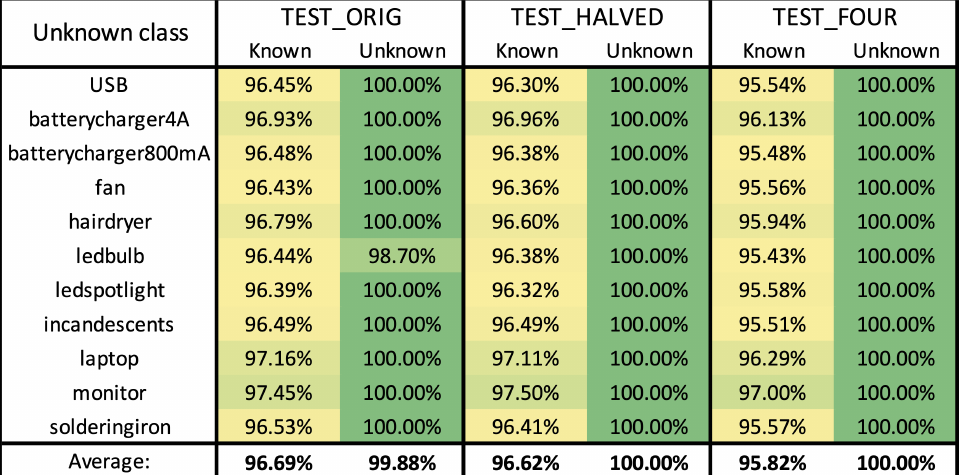
Figure 5. Average accuracy rates (of 100 runs) for SVM-based open-set recognition. The Known columns show the average accuracy rate for classifying all known samples when the class in the left column was selected as the unknown. The Unknown column shows the average accuracy rate of classifying the 250 unknown samples (when the class in the left column was selected as the